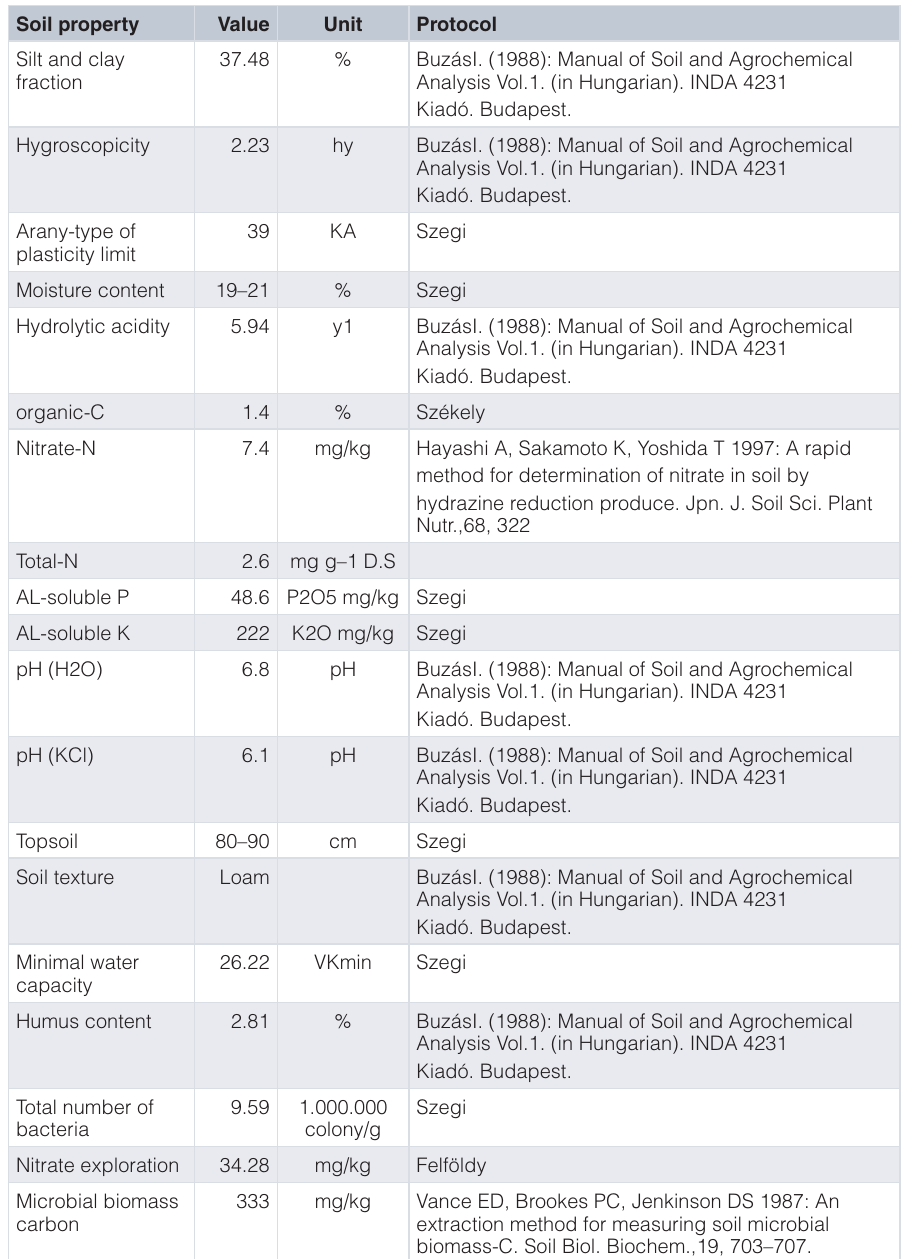
Table 1. Average values for a number of different soil